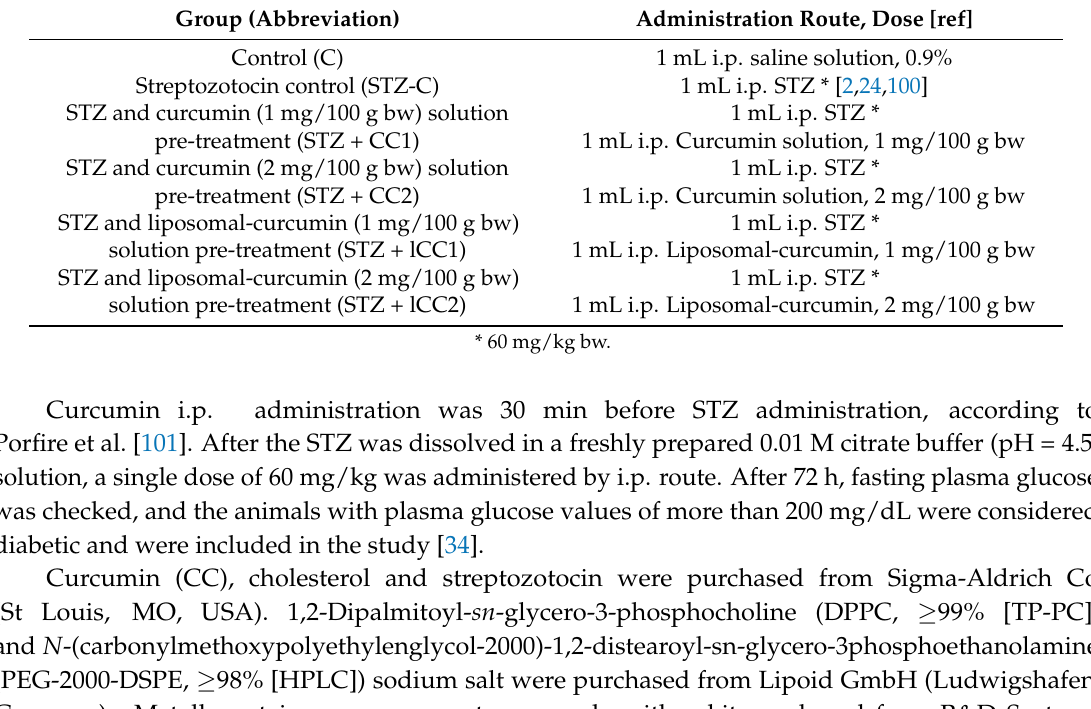
Table 2. Design of experiment on experimental diabetes mellitus with curcumin pre-treatment. Group (Abbreviation) Administration Route, Dose